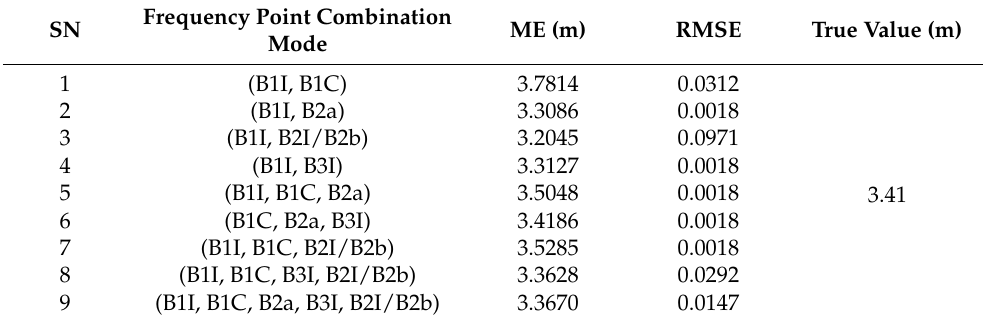
Table 6. Ranging performance under different frequency combination.